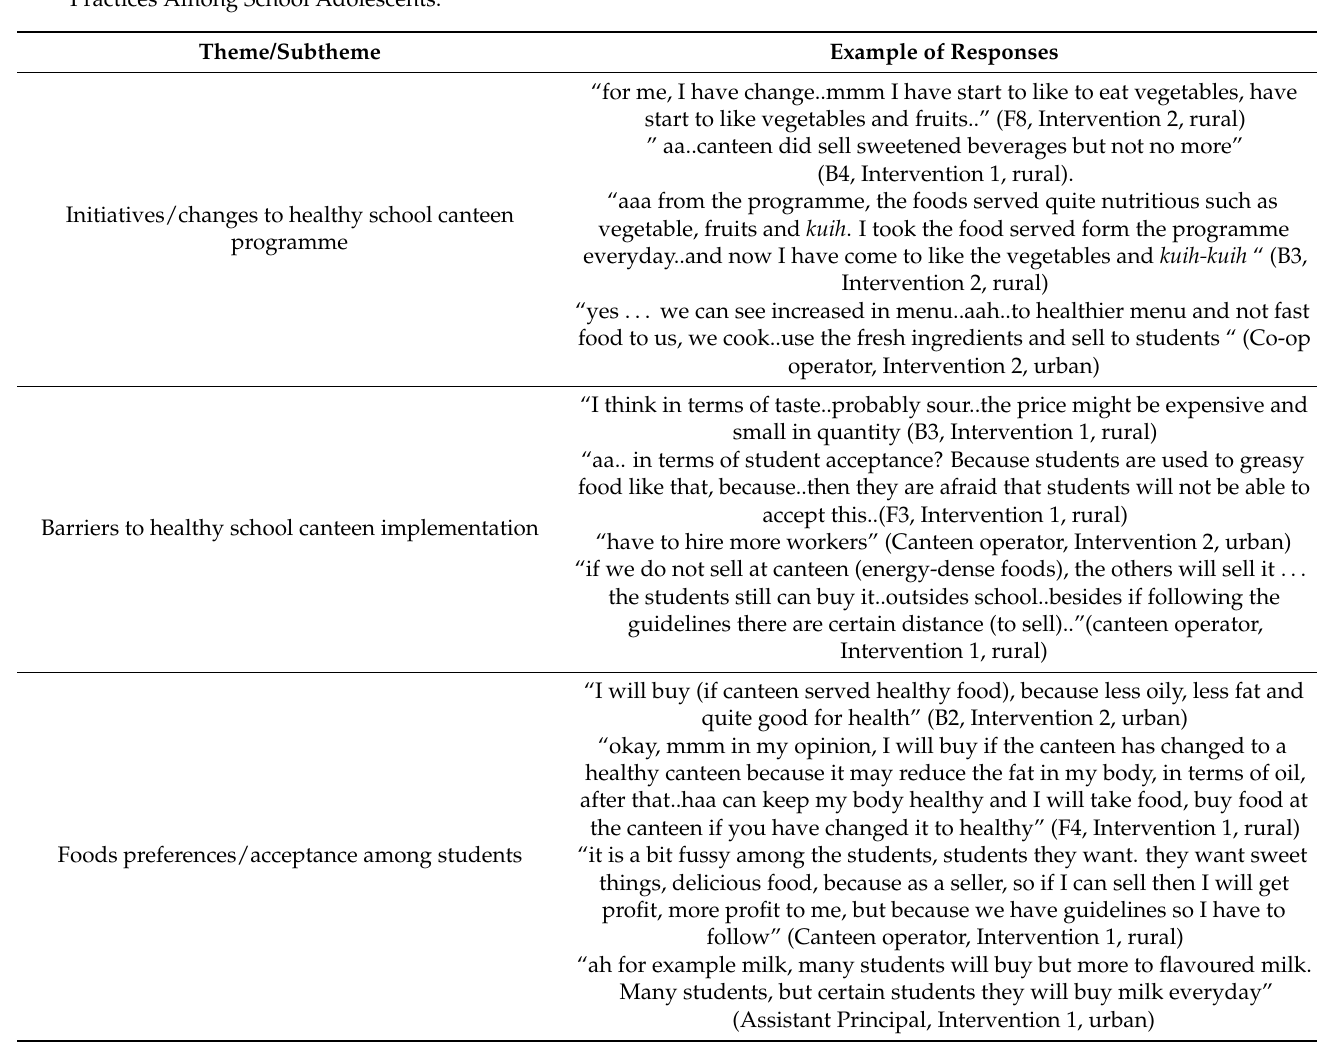
Table 5. Acceptance and Challenges to The Implementation of School-Based Intervention to Improve Healthy Eating Practices Among School